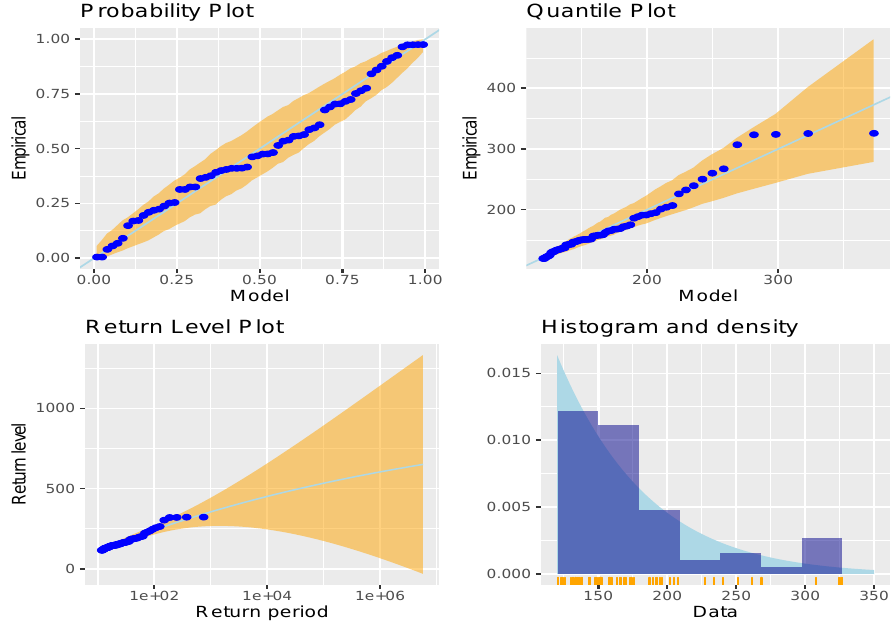
Figure 8. Diagnostic plots for the stationary GPD model (M1).